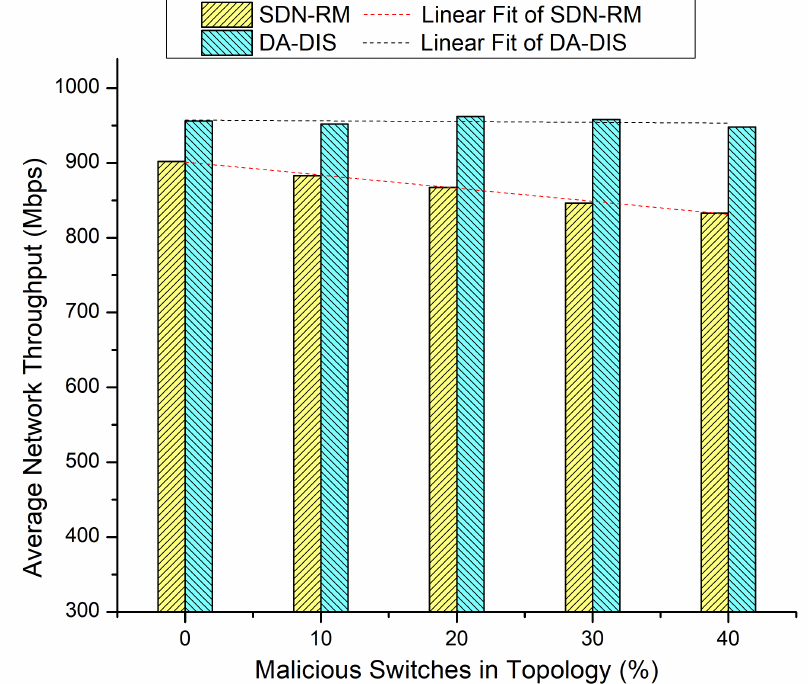
Figure 12. Throughput considering different numbers of malicious switches with E1 and E2